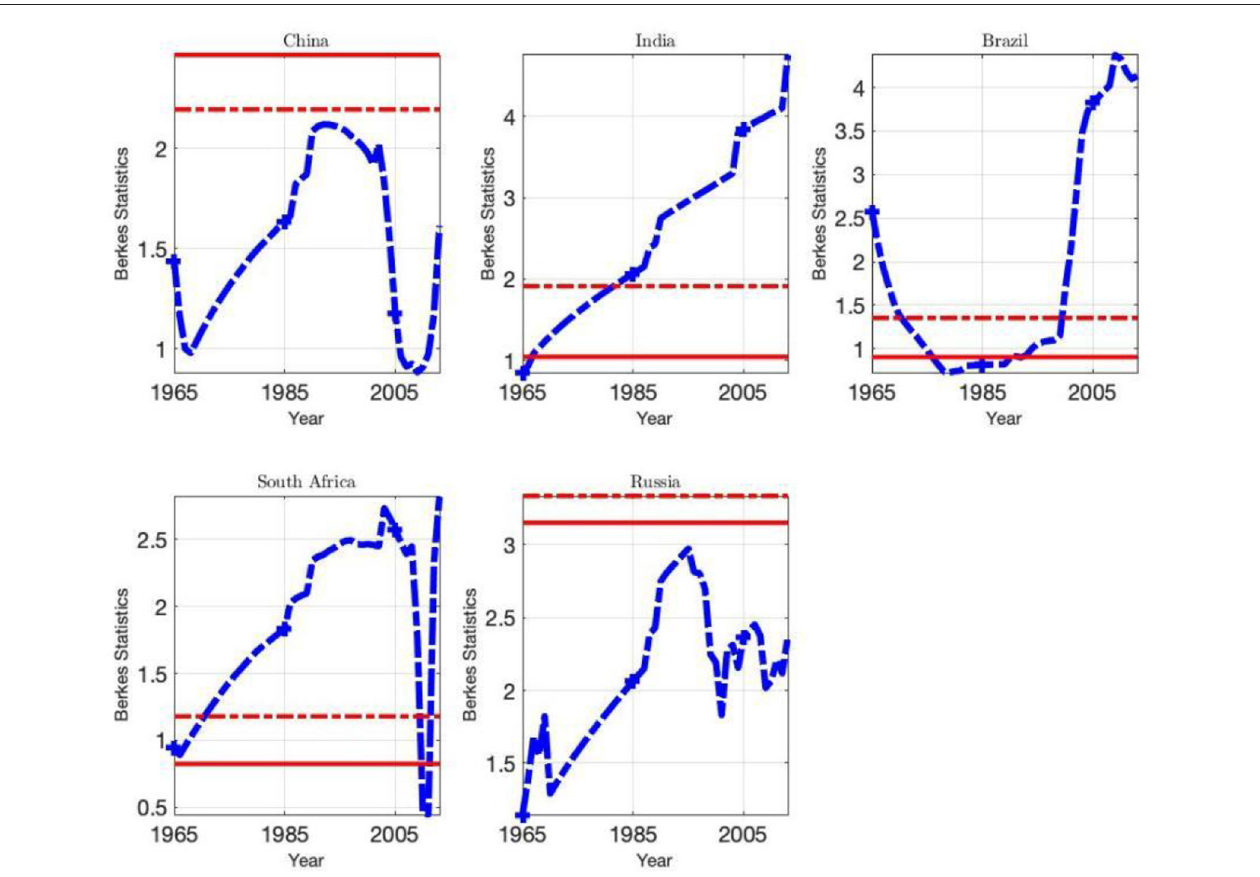
FIGURE 7 | M n statistics for BRICS. This graph plots Berkes statistics (blue lines) evolving over time. Red solid lines represent Monte Carlo critical values at 5% significant level; while red dash lines represent bootstrap critical values at 5% significant level. When red lines are located above the maxima of M statistics, Berkes test reject null hypothesis. With respect to Berkes statistics represented by Equation (22), empirical critical values are obtained by 2,000 repetitions of Monte Carlo simulation and 2,000 repetitions Bootstrap resample